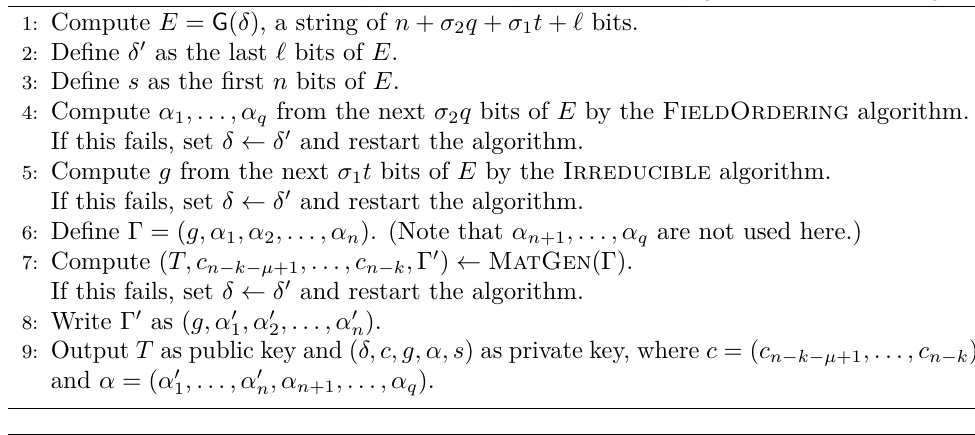
Algorithm 1 SeededKeyGen ( δ ) algorithm (using PRNG G ) [ABC + 20, Sect. 2.4.3].